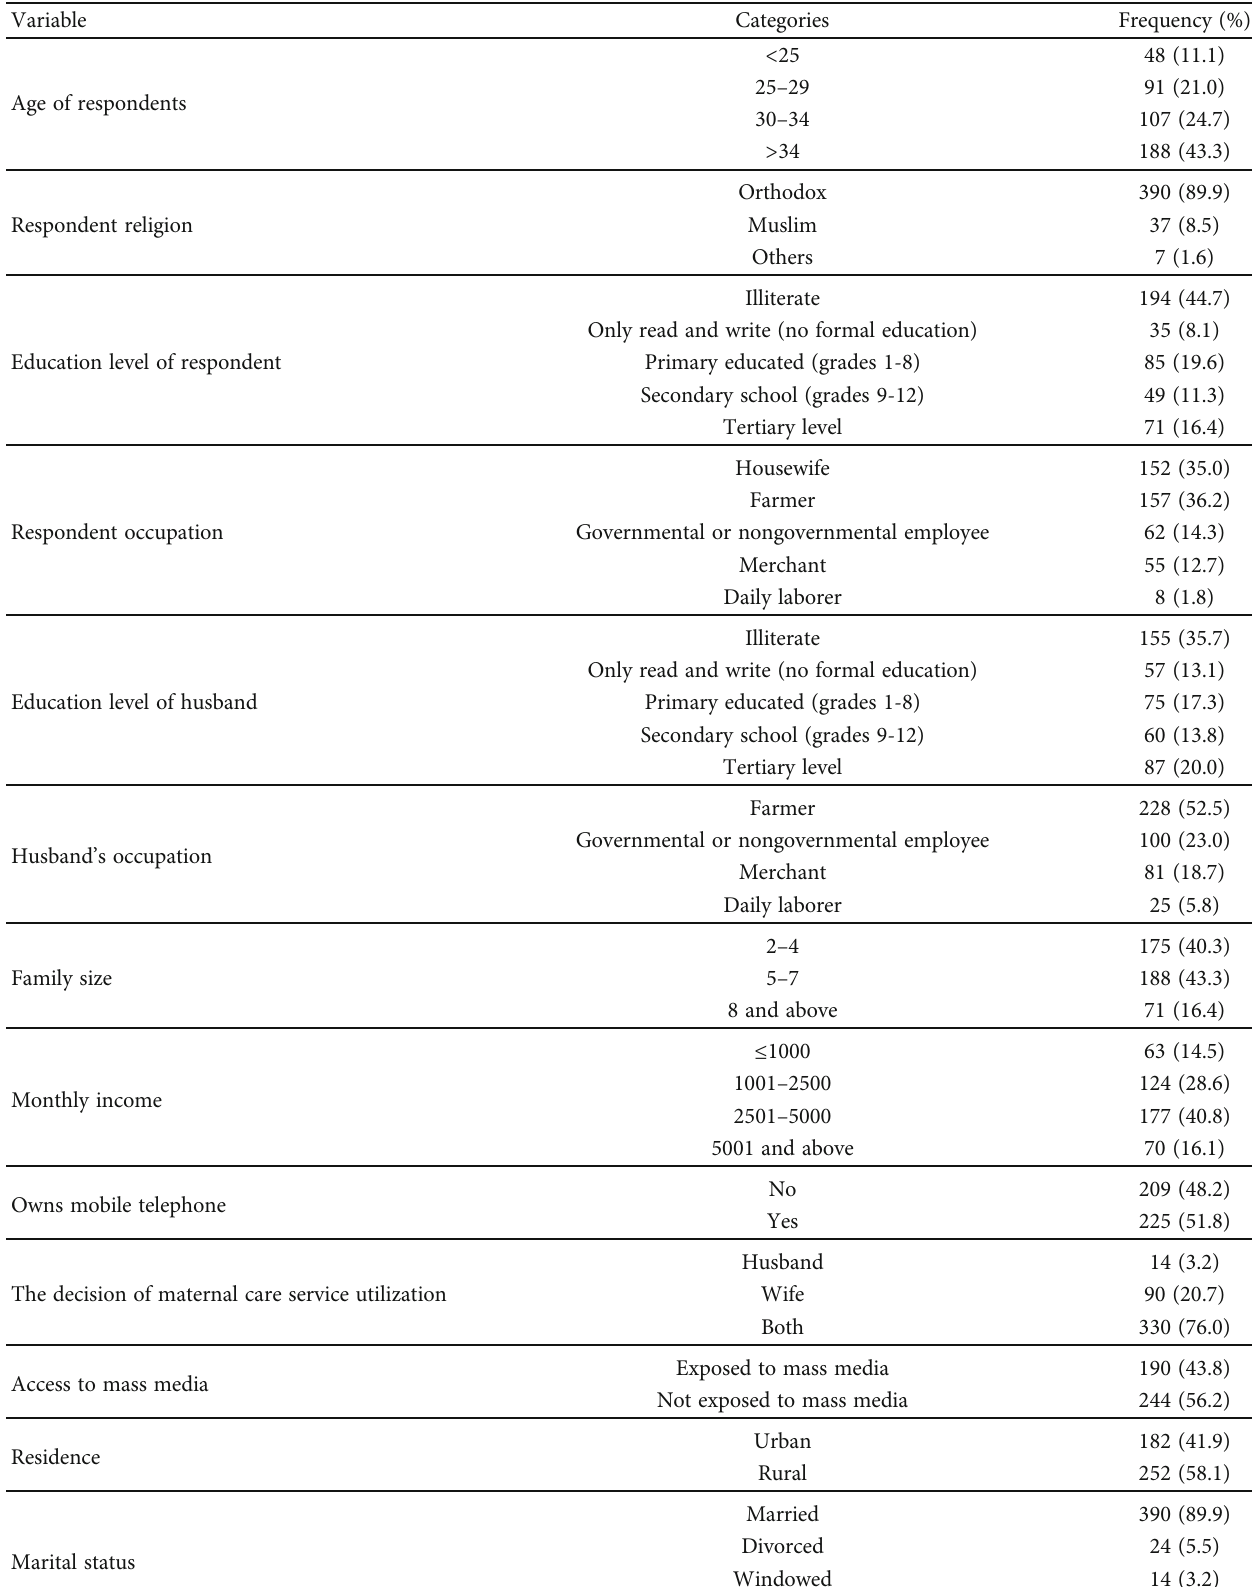
Table 1: Sociodemographic characteristics of respondents in South Gondar